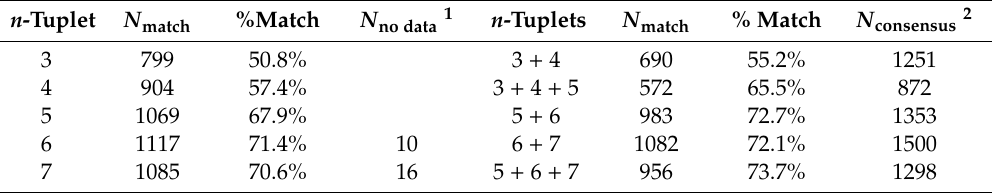
Table 3. Number of matches between the signs of score changes and melting temperature changes upon